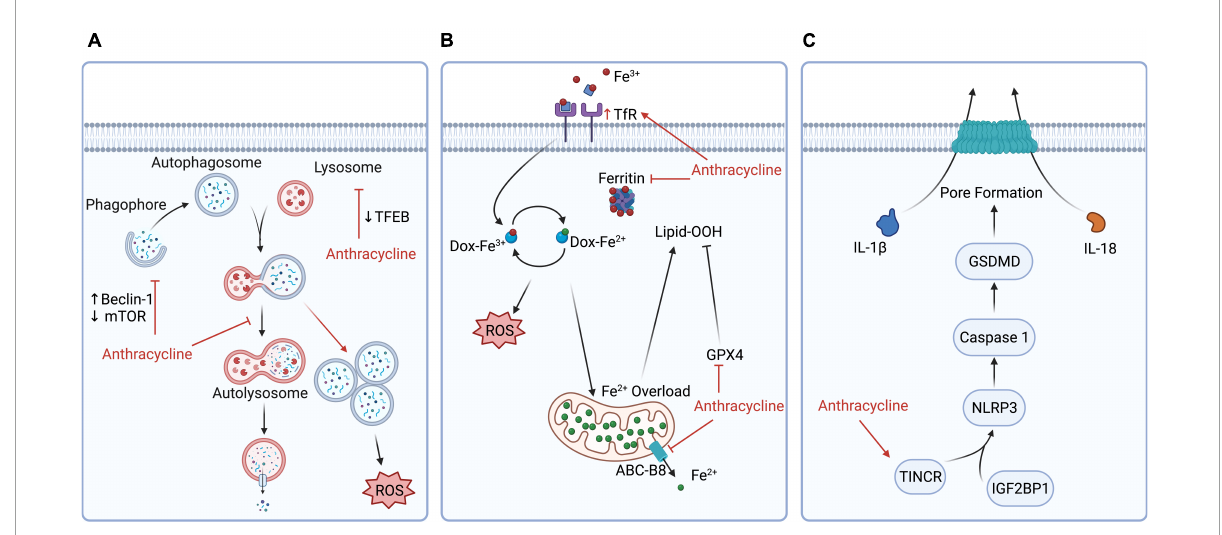
FIGURE2 Additional anthracycline cardiotoxicity mechanisms for the development of novel molecular nuclear probes. Highlighted mechanisms have not yet been targeted using a nuclear imaging strategy, and certain key molecular or biochemical targets are presented for the potential development of new SPECT/PET tracers. (A) Anthracyclines impair autophagy by compromising lysosomal acidification, increasing beclin-1 expression, inhibiting mTOR, and inhibiting transcription factor EB, thereby blocking autophagic flux and causing an accumulation of autolysosomes that leads to increased ROS production. New probes may be developed to target molecules implicated in the accumulation of undegraded autolysosomes. (B) Anthracycline-induced ferroptosis is caused by iron overload through upregulation of TfR, inactivation of ferritin, inhibition of ABC-B8, and downregulation of GPX4, which may be targets for probe development. (C) Anthracycline induces pyroptosis by upregulating TINCR, which increases the expression of NLRP3 and caspase 1 activation. Future probes may for example target NLRP3 or caspase1. ABC-B8, ATP binding cassette subfamily B member 8; Dox, doxorubicin; GPX4, glutathione peroxidase 4; GSDMD, gasdermin D; IGF2BP1, insulin-like growth factor 2 mRNA binding protein 1; IL, interleukin; Lipid-OOH, lipid hydroperoxides; mTOR, mammalian target